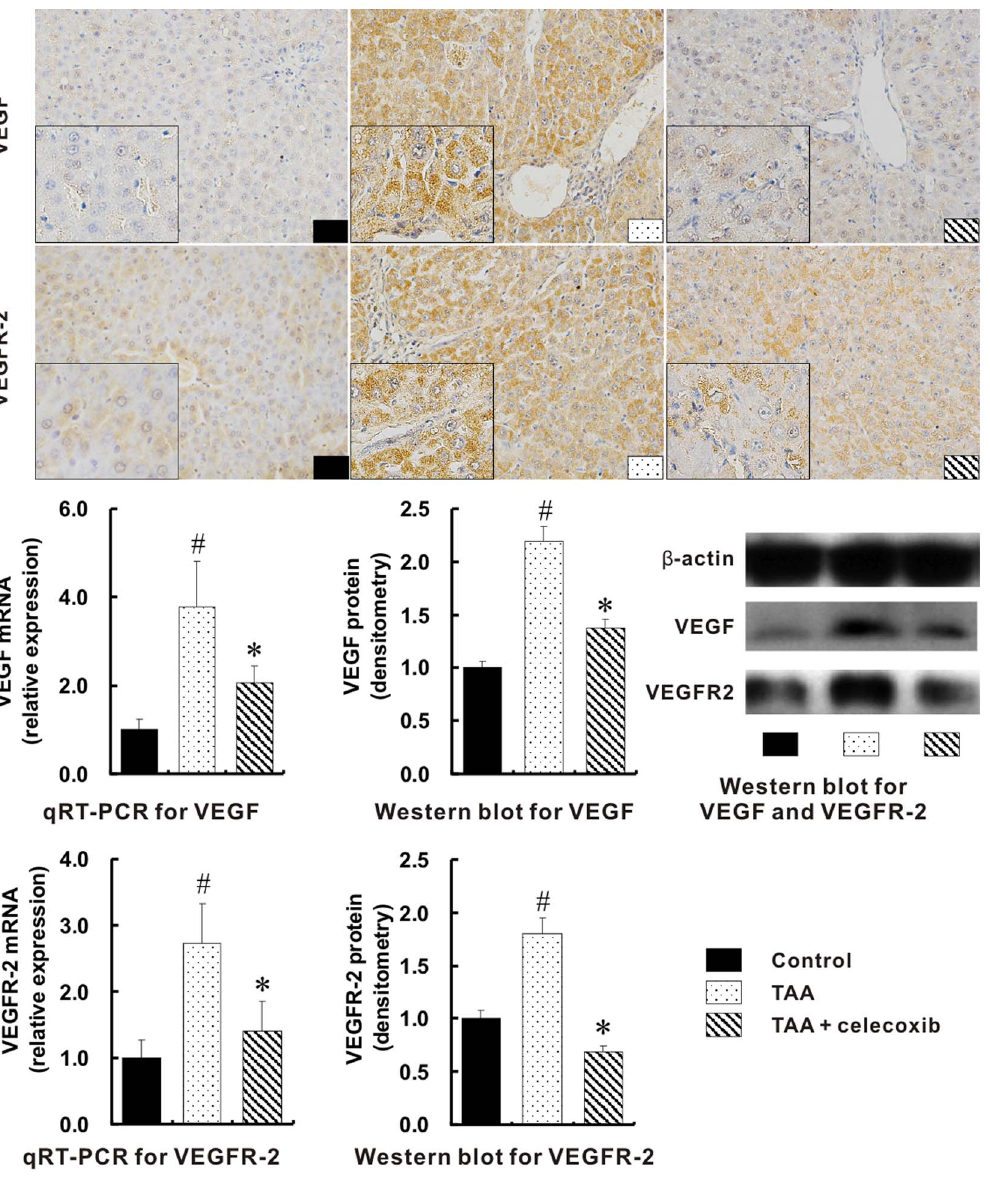
Figure 3. Suppression of angiogenetic factors by celecoxib treatment. Much more positive expressions for VEGF and VEGFR-2 were visualized in TAA group (1st - 2nd panels, Immunohistochemical stain, 6 400 magnifications; inserts, 6 1000 magnifications). The mRNA and protein levels of hepatic VEGF and VEGFR-2 in TAA group measured with qRT-PCR and Western blot respectively were the highest among three groups. # p , 0.01 vs . control group; * p , 0.01 vs . TAA